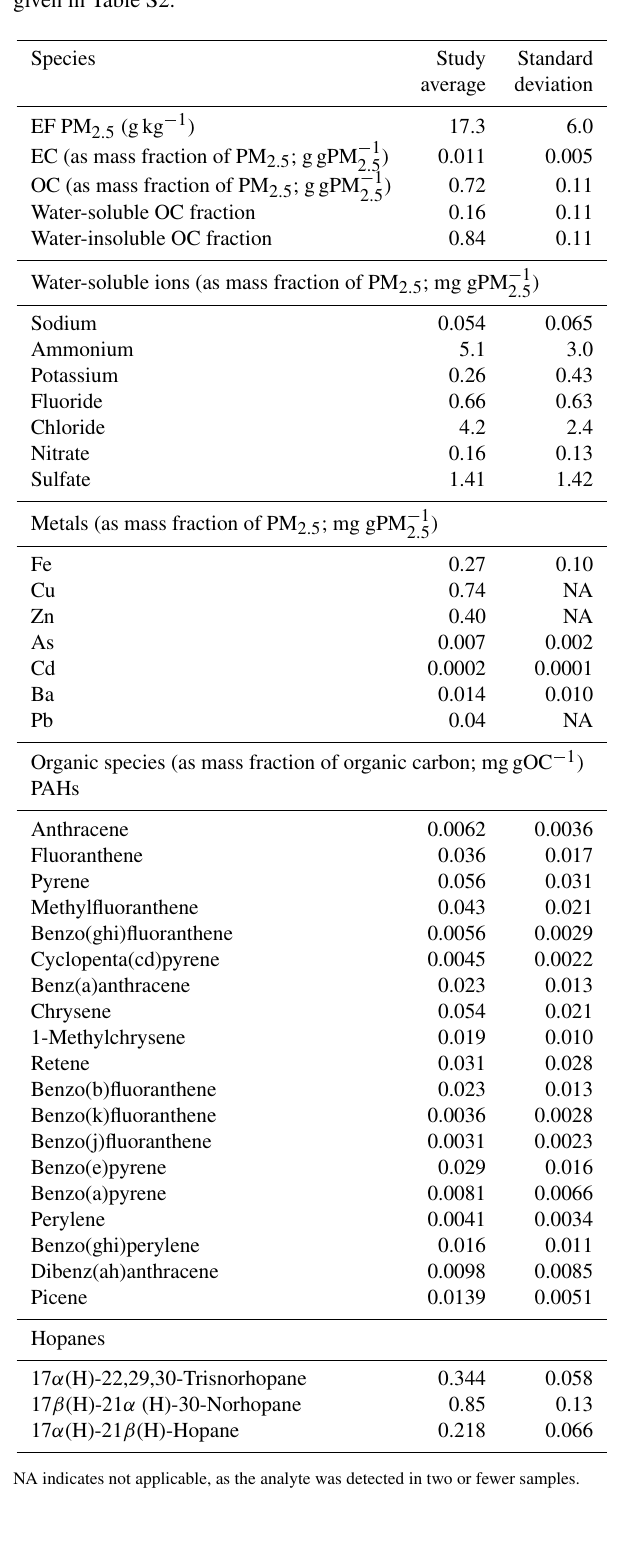
Table 2. Average emission factors for PM 2 . 5 , EC, OC, water- soluble ions, metals (as mass fraction of PM 2 . 5 ) , and organic species normalized to organic carbon mass. Individual EF data are given in Table